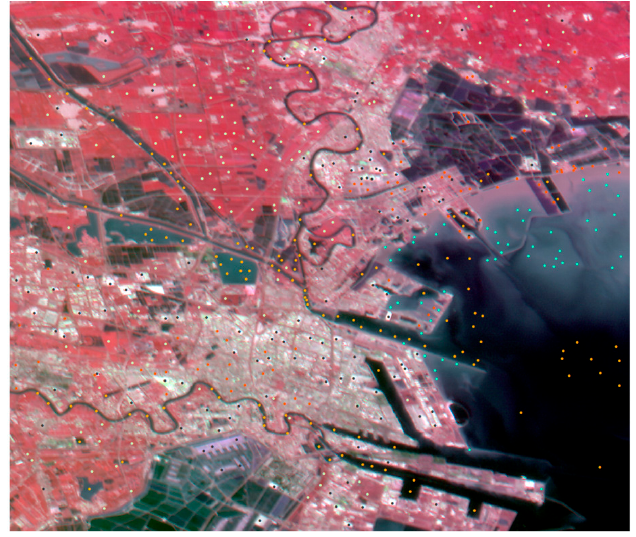
Figure 6. Distribution of the 512 sample points which were selected from the SRR image for Experiment 1 that was obtained using the proposed MSR-NCHOTV algorithm.